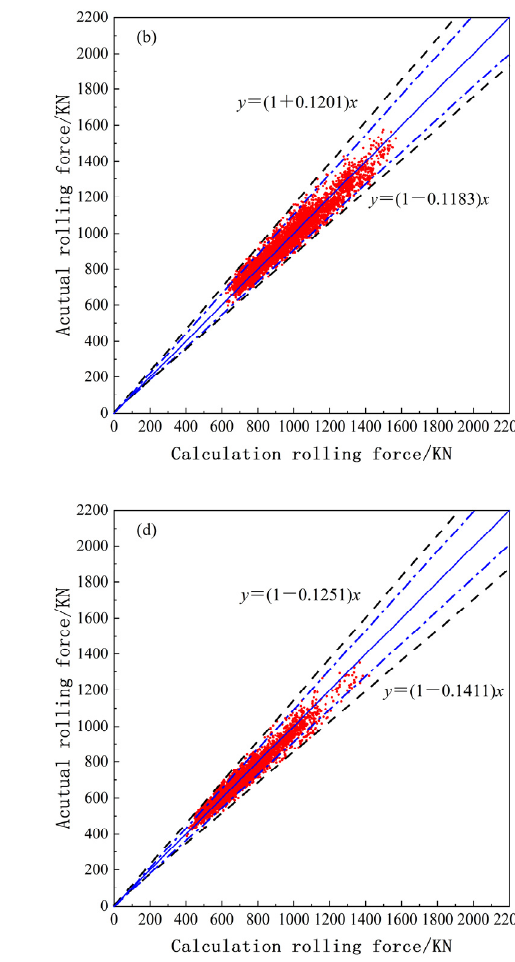
Figure 9. Comparison of rolling force qualification rates: ( a ) δ ZP ≤ 0.05, and ( b ) δ ZP ≤ 0.1. 4.2. Calculation Result of RFDPM BP neural network training also adopts 5000 data points; the ratio of the training set, test set, and verification set is 7:2:1. A standard normal distribution, with a mean value of 0 and a standard deviation of 1, was used for weight initialization and the number of training sessions was set to 50,000. Two hundred groups of data were randomly selected from the calculated results compensated for by RFDPM and were compared with the actual values. As shown in